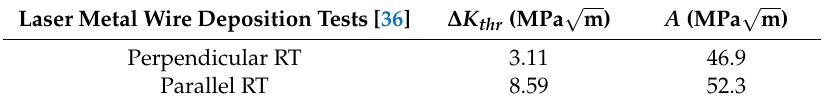
Figure 2. ( a ) Measured, from [36], and computed crack growth curves in two directions of laser metal wire deposited Ti-6Al-4V; ( b ) Exponent error of the fitted curves as computed using Equation (5). Equation (4) was again used through a global optimization scheme to compute these curves. The identified values of ∆(cid:1837) (cid:3047)(cid:3035)(cid:3045) and A are given in Table 2. As per References [4,10,17], and as can be seen in the experimental data, the threshold values for these two tests differ. This is a somewhat expected result, since data are available only in the Paris region. As can be seen in Figure 2a, the resultant computed curves are in reasonably good agreement with the measured data, an observation that is also corroborated by the error plots in Figure 2b. Table 2. Values of ∆ K thr and A used in Figure 2 and identified by global optimization of Equation (4). Laser Metal Wire Deposition Tests [36]